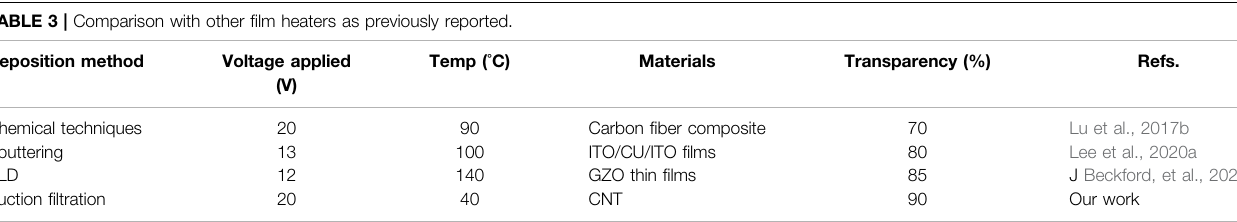
Figure 7 exhibits the thermal response time and resistance stability of the FTFHs. As shown in Figure 7A , the generated temperature of FTFHs increases with the increase of time, but